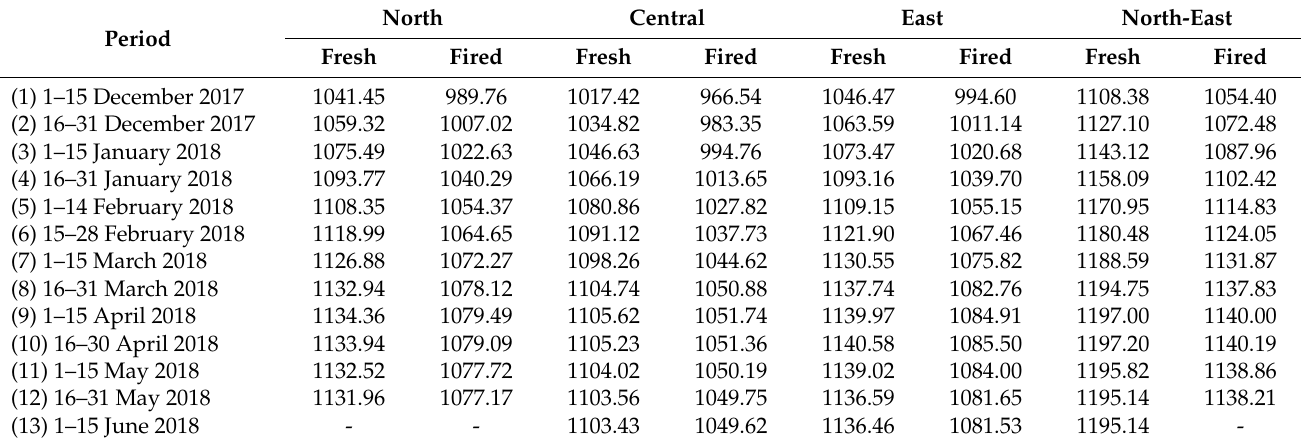
Table 5. The price (baht/tonne) of fresh and fired sugarcane in each region for crop year 2018/19. North Central East North-East Period Fresh Fired Fresh Fired Fresh Fired Fresh